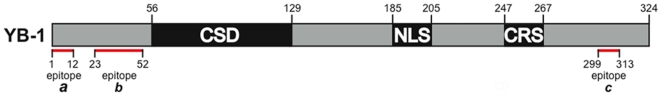
Linear representation of YB-1.YB-1 contains a highly conserved cold shock domain (CSD); a nuclear localization signal (NLS); a cytoplasmic retention signal (CRS); red bars indicate the epitopes (a–c) for YB-1 antibodies.